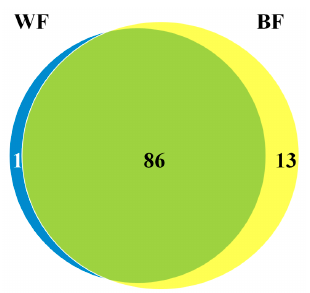
Figure 1. Venn diagram of blueberry miRNAs in the libraries of white (WF) and blue fruits (BF).